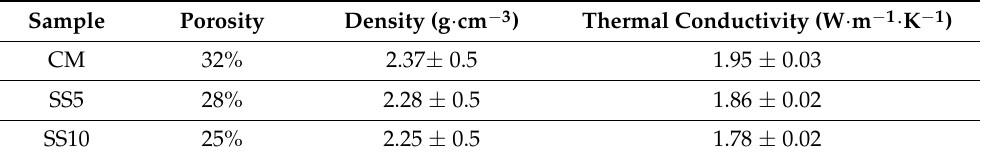
Table 8. Variation of the thermal conductivity, porosity, and density of the concretes elaborated with different proportions of SS after 28 days of curing. Standard deviations are calculated for 3 replicates.